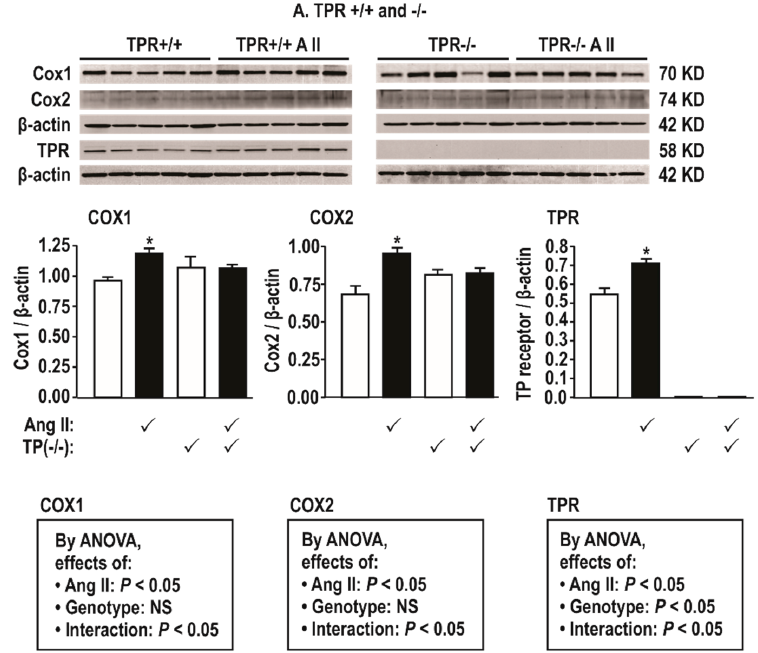
Figure 2. Angiotensin II infusion at 400 ng·kg –1 min –1 × 14 days increases mesenteric resistance arteriolar protein expression for cyclooxygenase (COX) 1 and 2 and thromboxane prostanoid receptors (TPRs) in TPR wild type but not knockout mice. Mean ± SEM values ( n = 5 per group). Compared to without angiotensin II infusion: *, P < 0.05. Antioxidants 2019 , 8 , x FOR PEER REVIEW